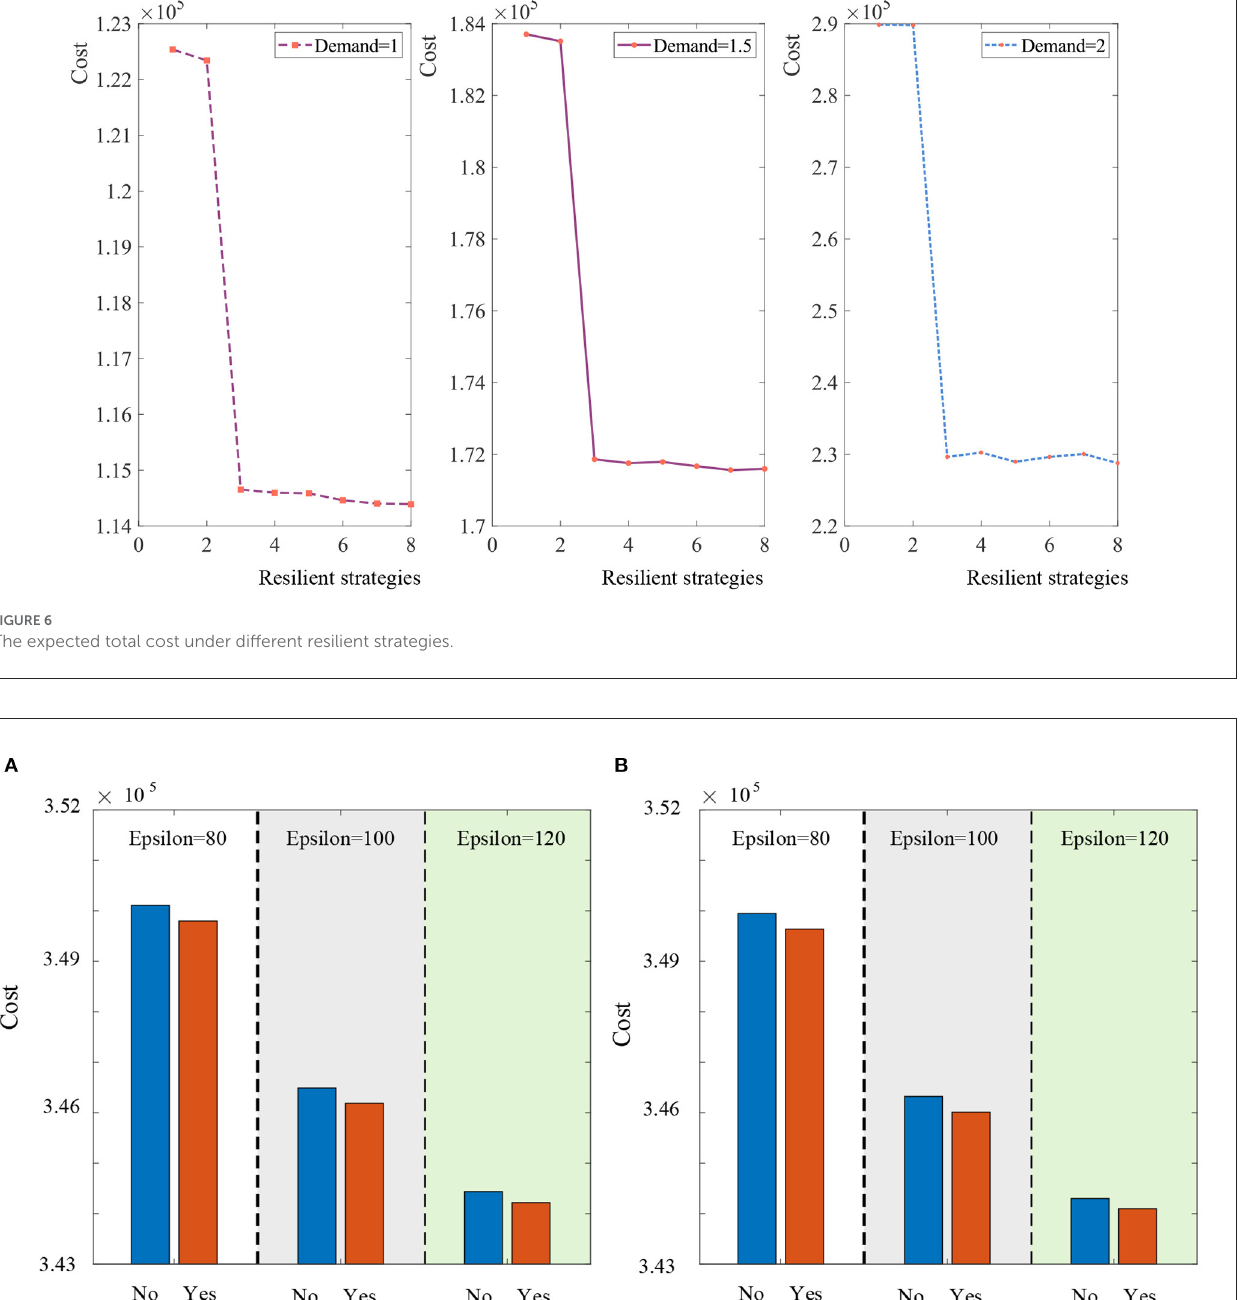
multiple sourcing and lateral transshipment resilience